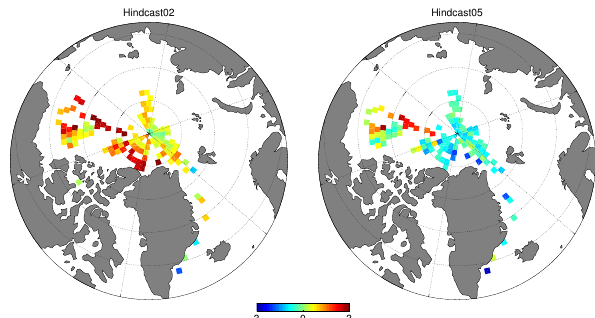
Figure 14. Difference (in metres, model minus observation) be- tween the sea-ice thickness from hindcast H02 (left) and hindcast H05 (right) and measurements from ice mass balance buoys for the period 2003–2009 averaged across boxes measuring approximately 100km square.